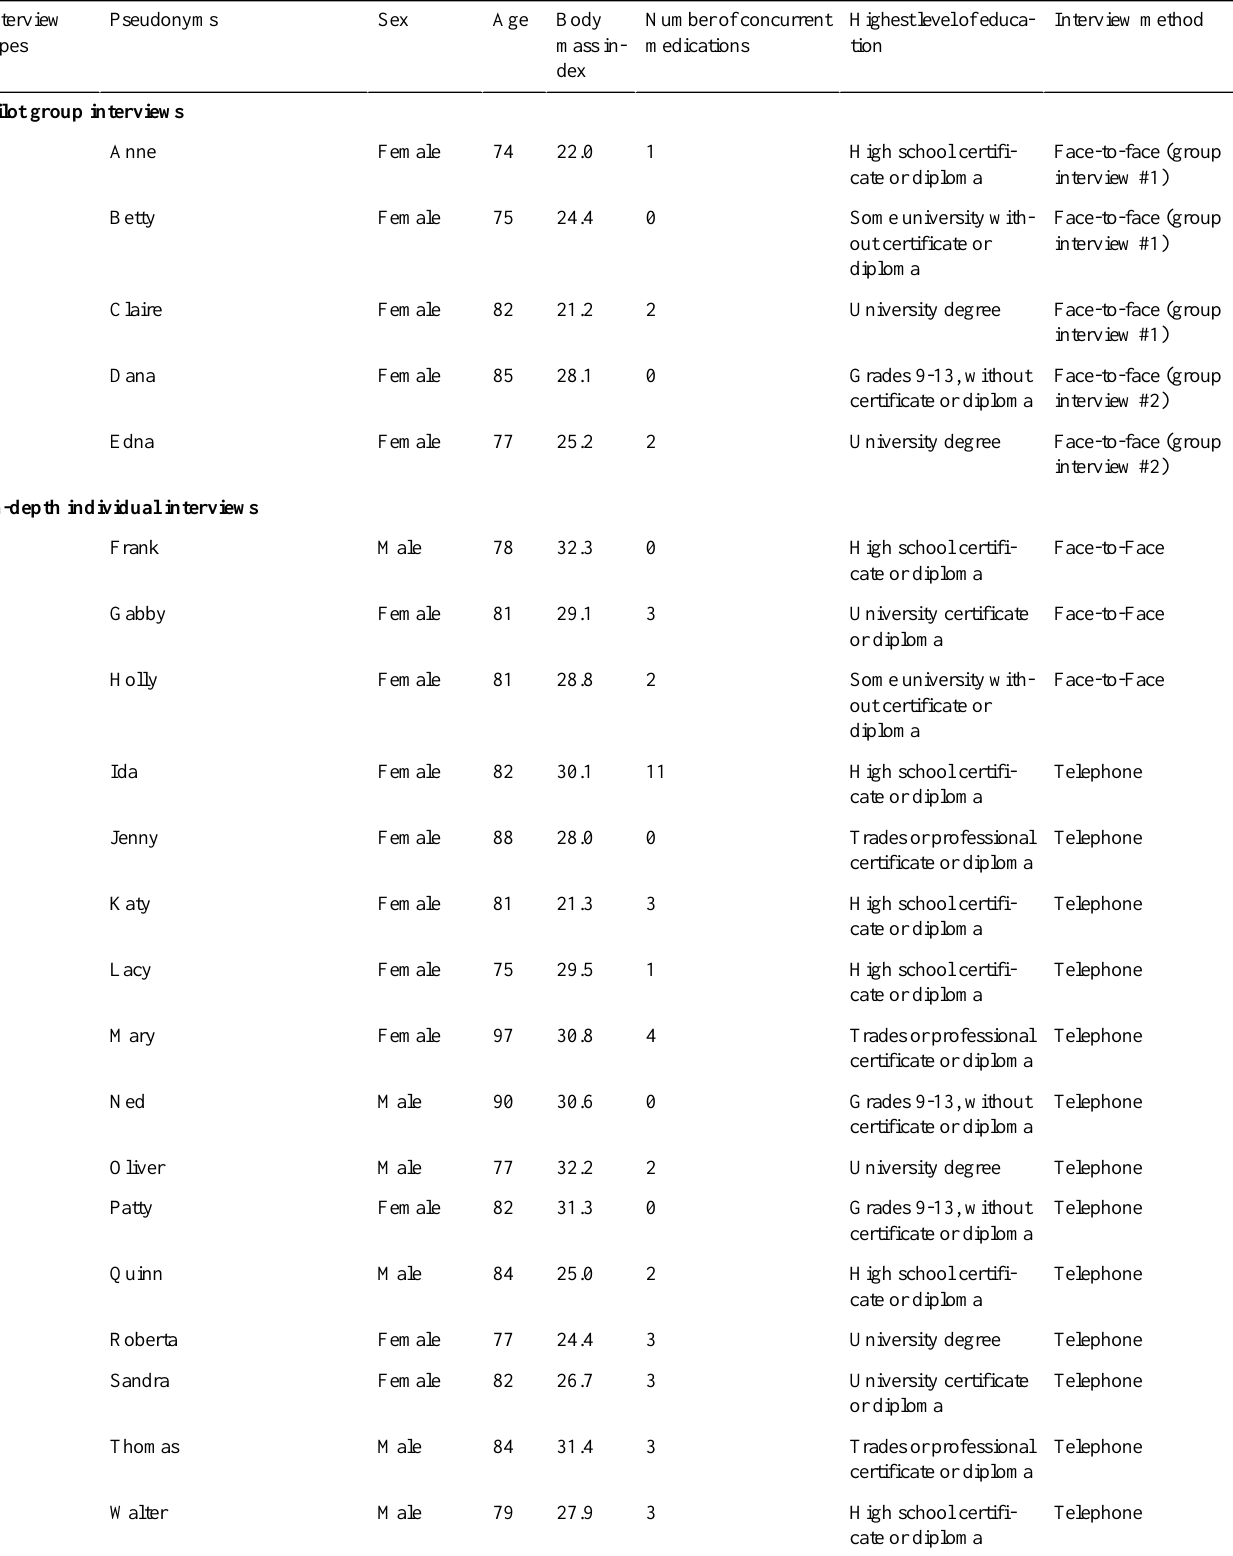
Table 1. Characteristics of participants who completed group and individual